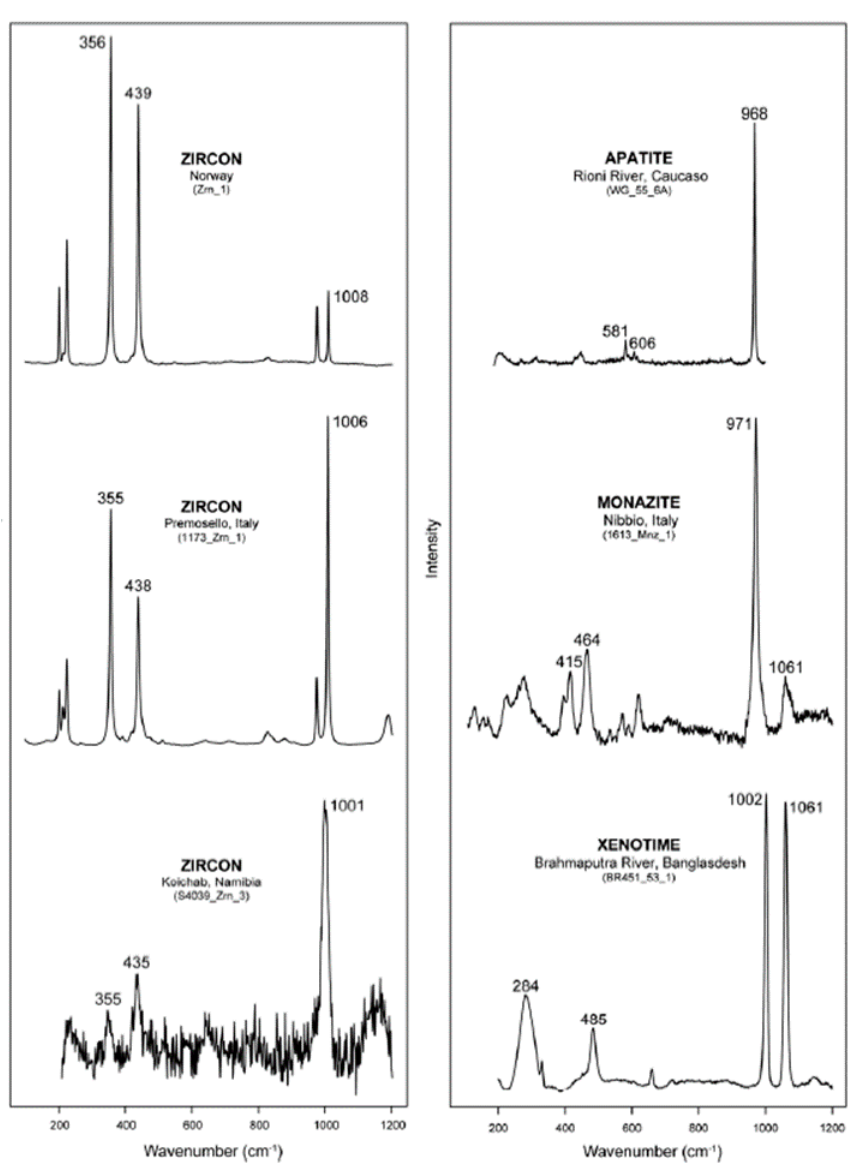
Figure 13. Raman spectra of some common heavy minerals of different origin, reproduced with permission from [114]. permission from